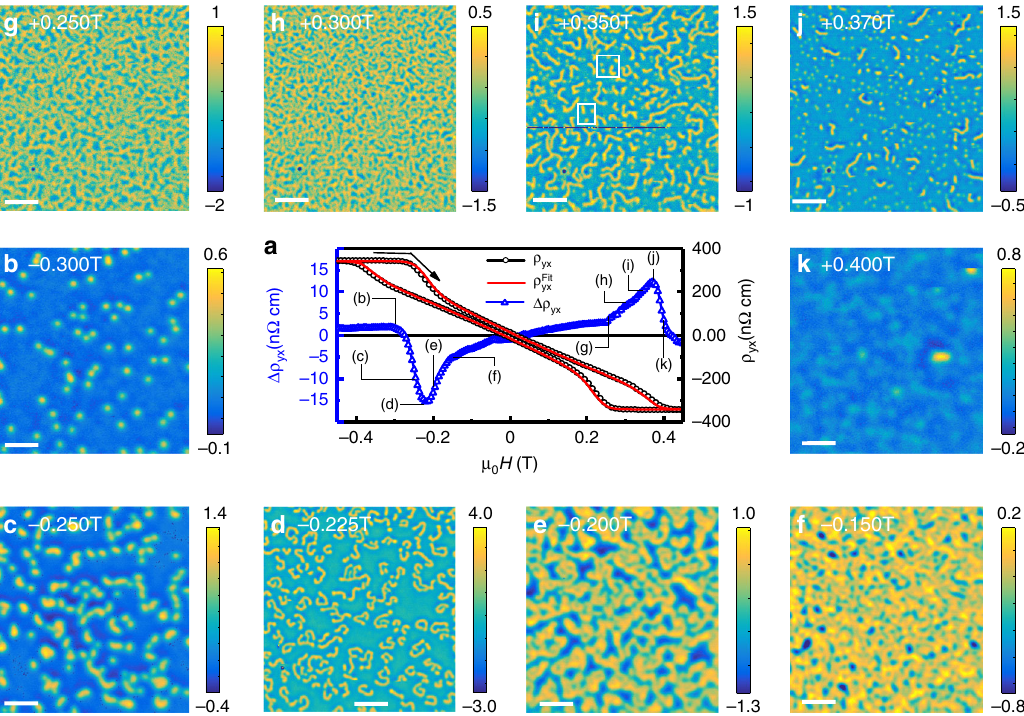
ð H Þ . The black arrow TH